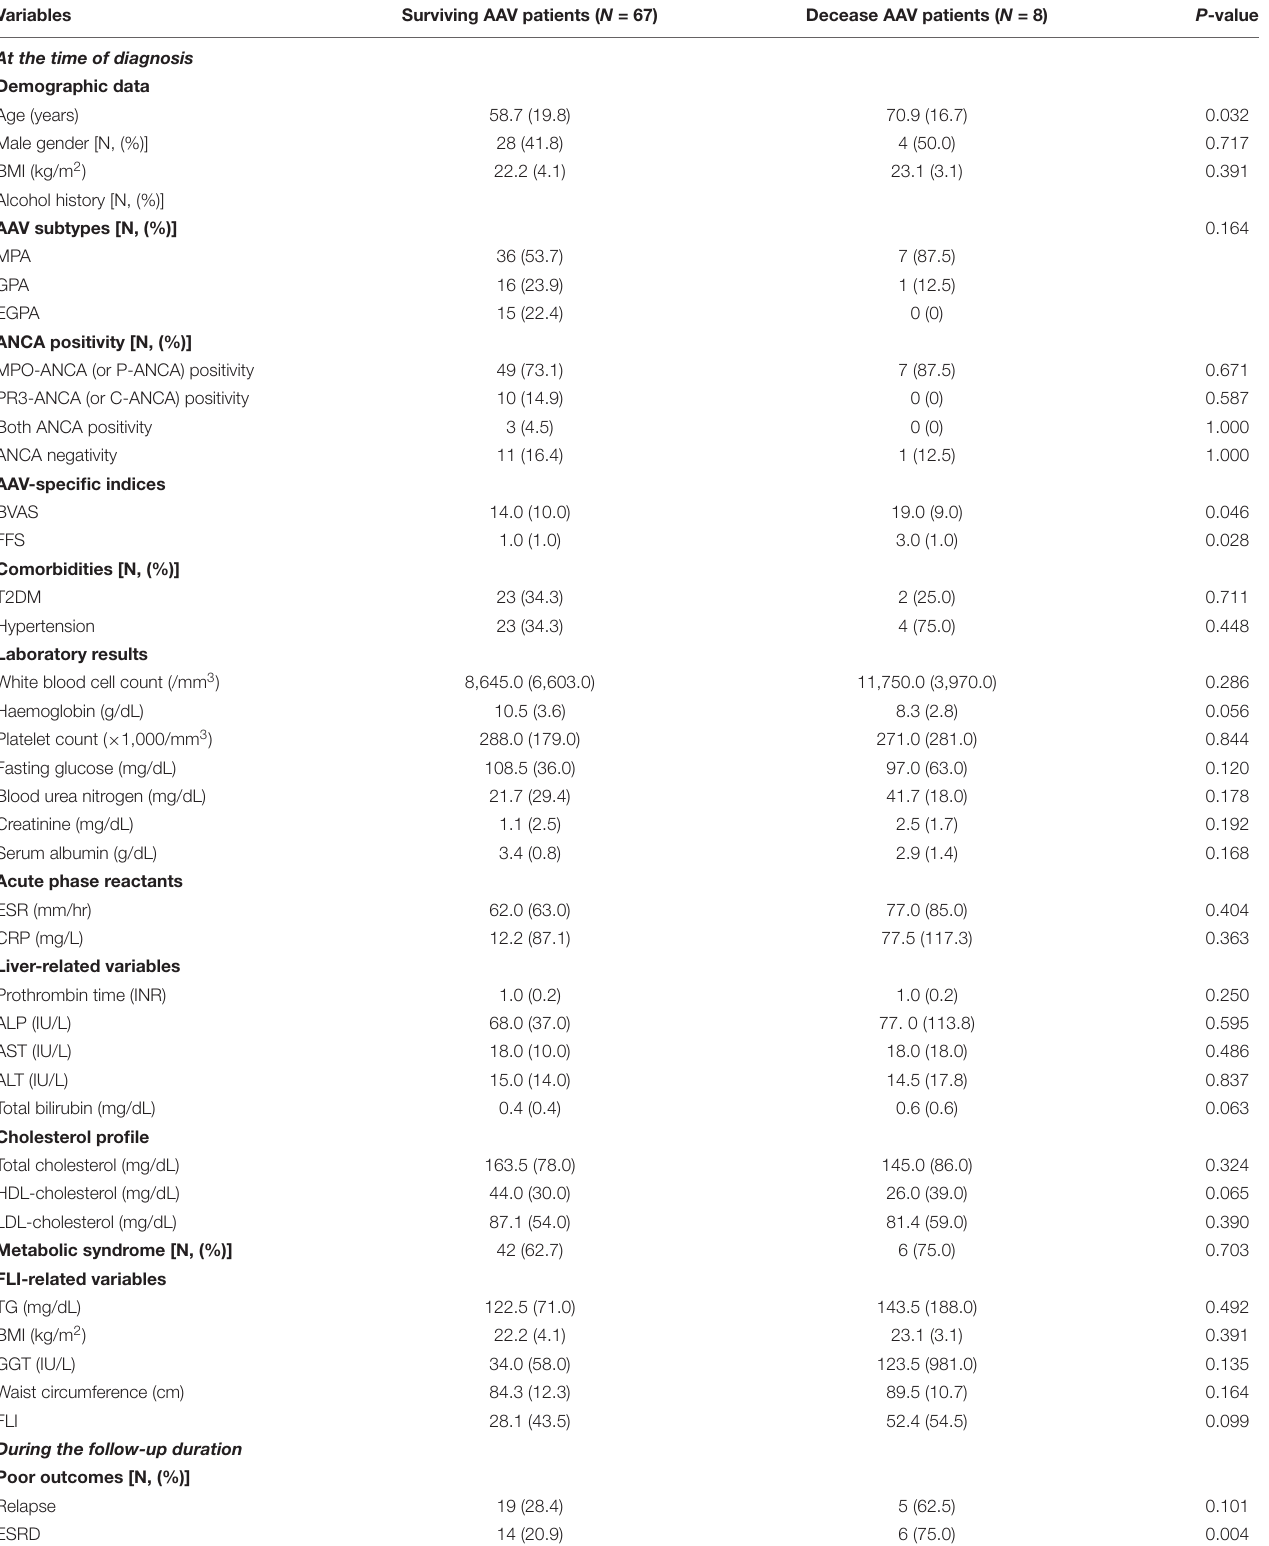
TABLE 2 | Comparison of variables between surviving and deceased AAV patients. Variables Surviving AAV patients ( N =